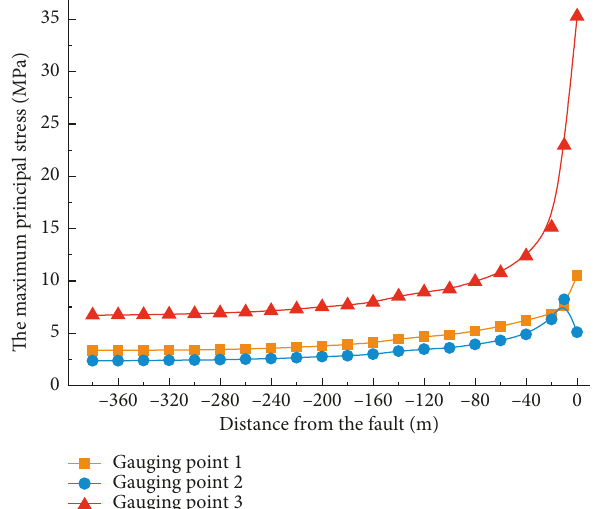
Figure 9: The states of the principal stress at the fault during the working face